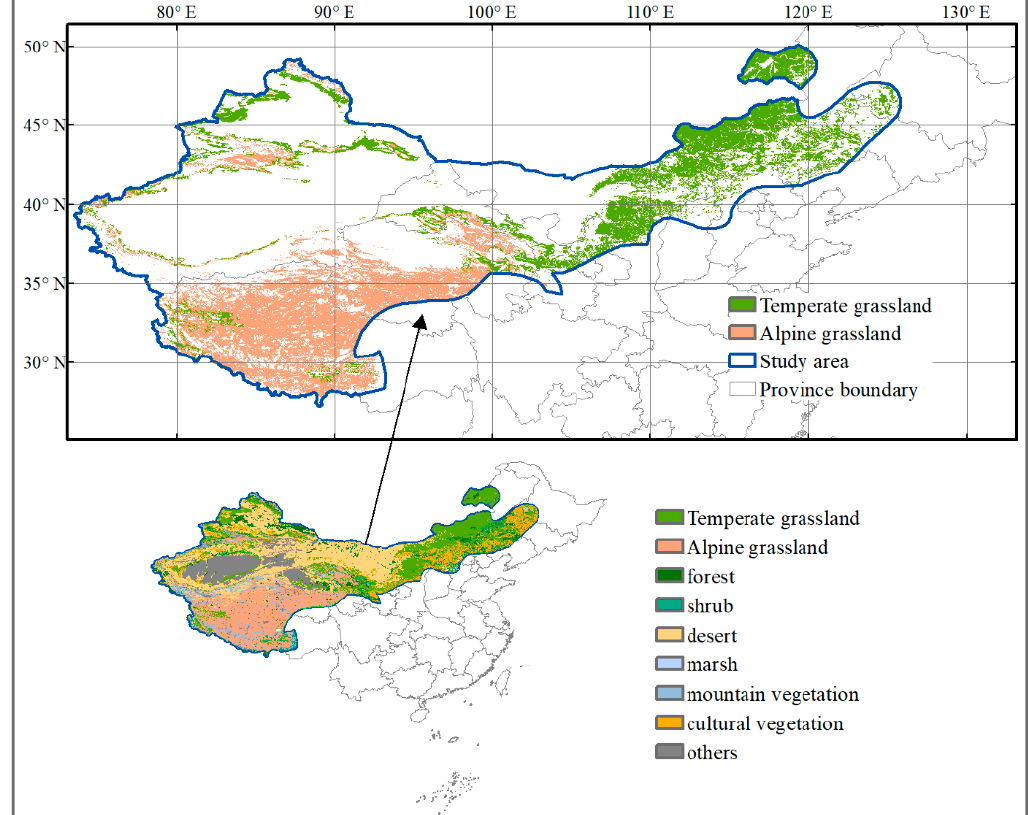
Figure 1. Geographic location of the study area.